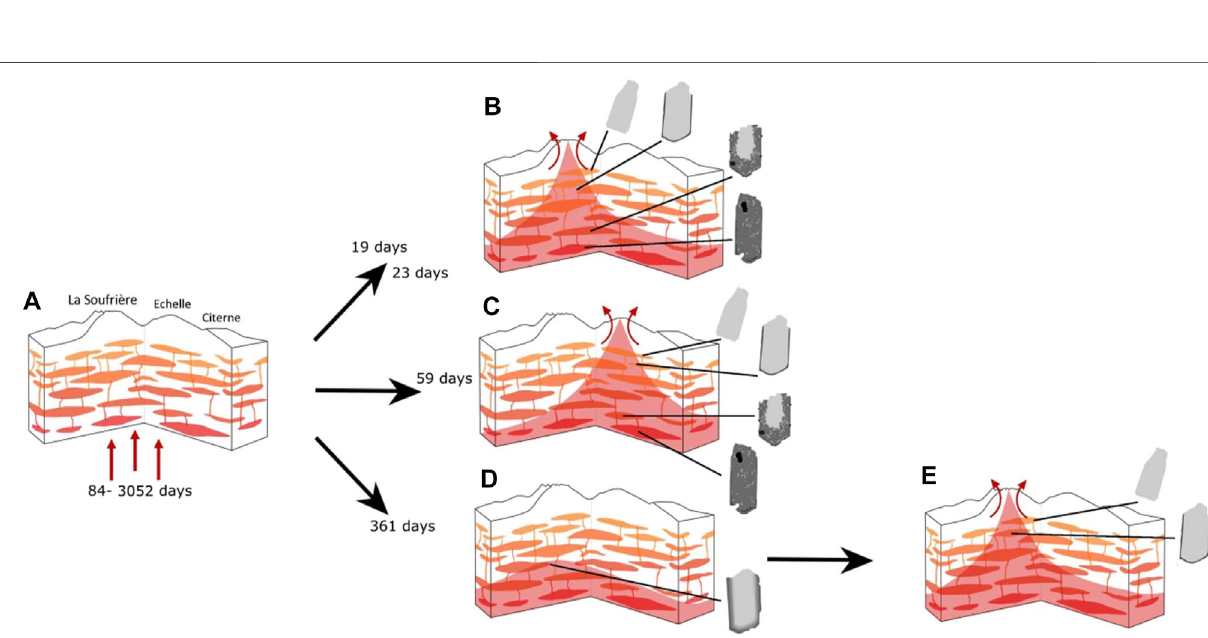
Echelle or the eruption of a monogenetic cone may result in different expected timescales of magmatic processes preceding eruptions. In a shallow storage region, crystals interact with melt shortly before eruption and could explain the crystals recording